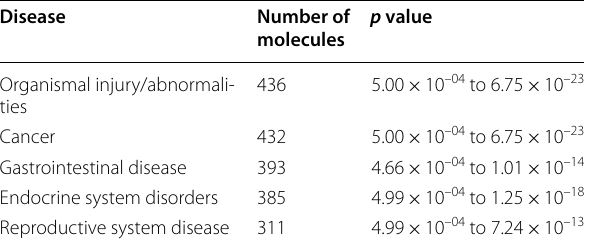
Table 5 Top five diseases or disorders revealed by Ingenuity Pathway Analysis